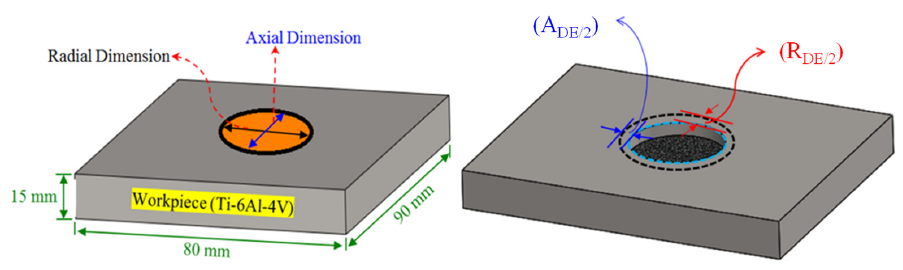
Figure 2. Schematic of radial and axial dimensions and definition of the corresponding errors.